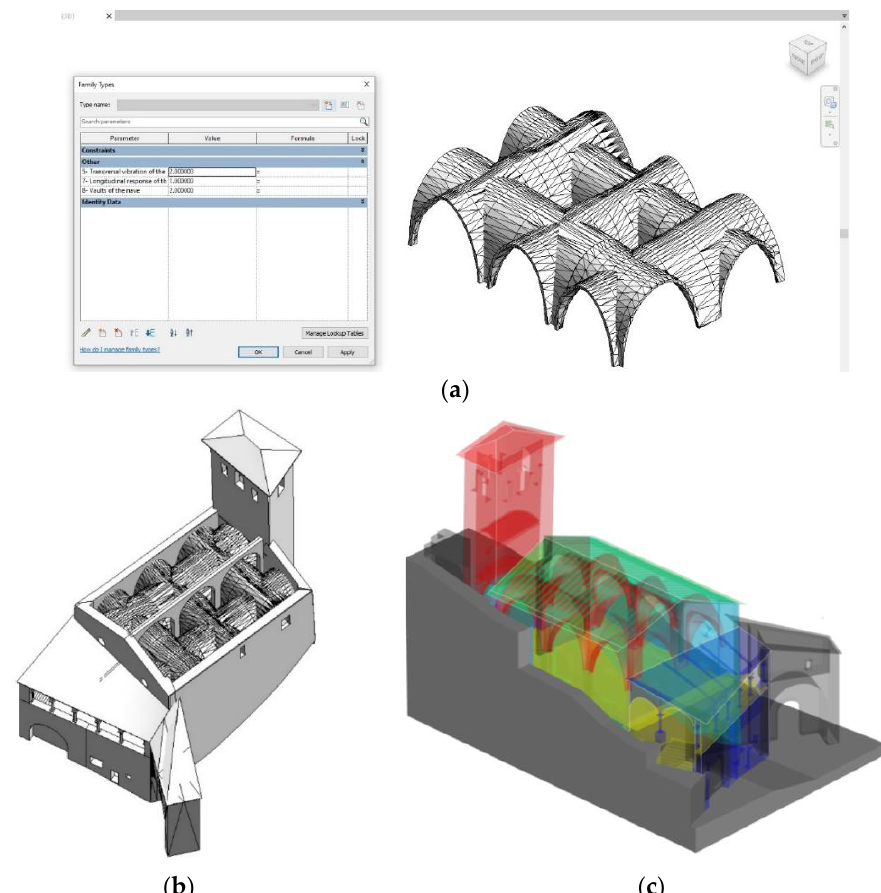
Figure 13. The as-built modeling steps for deriving accurate surfaces from point clouds. ( a , b ); and final microelement 3D volumetric model ( c ).